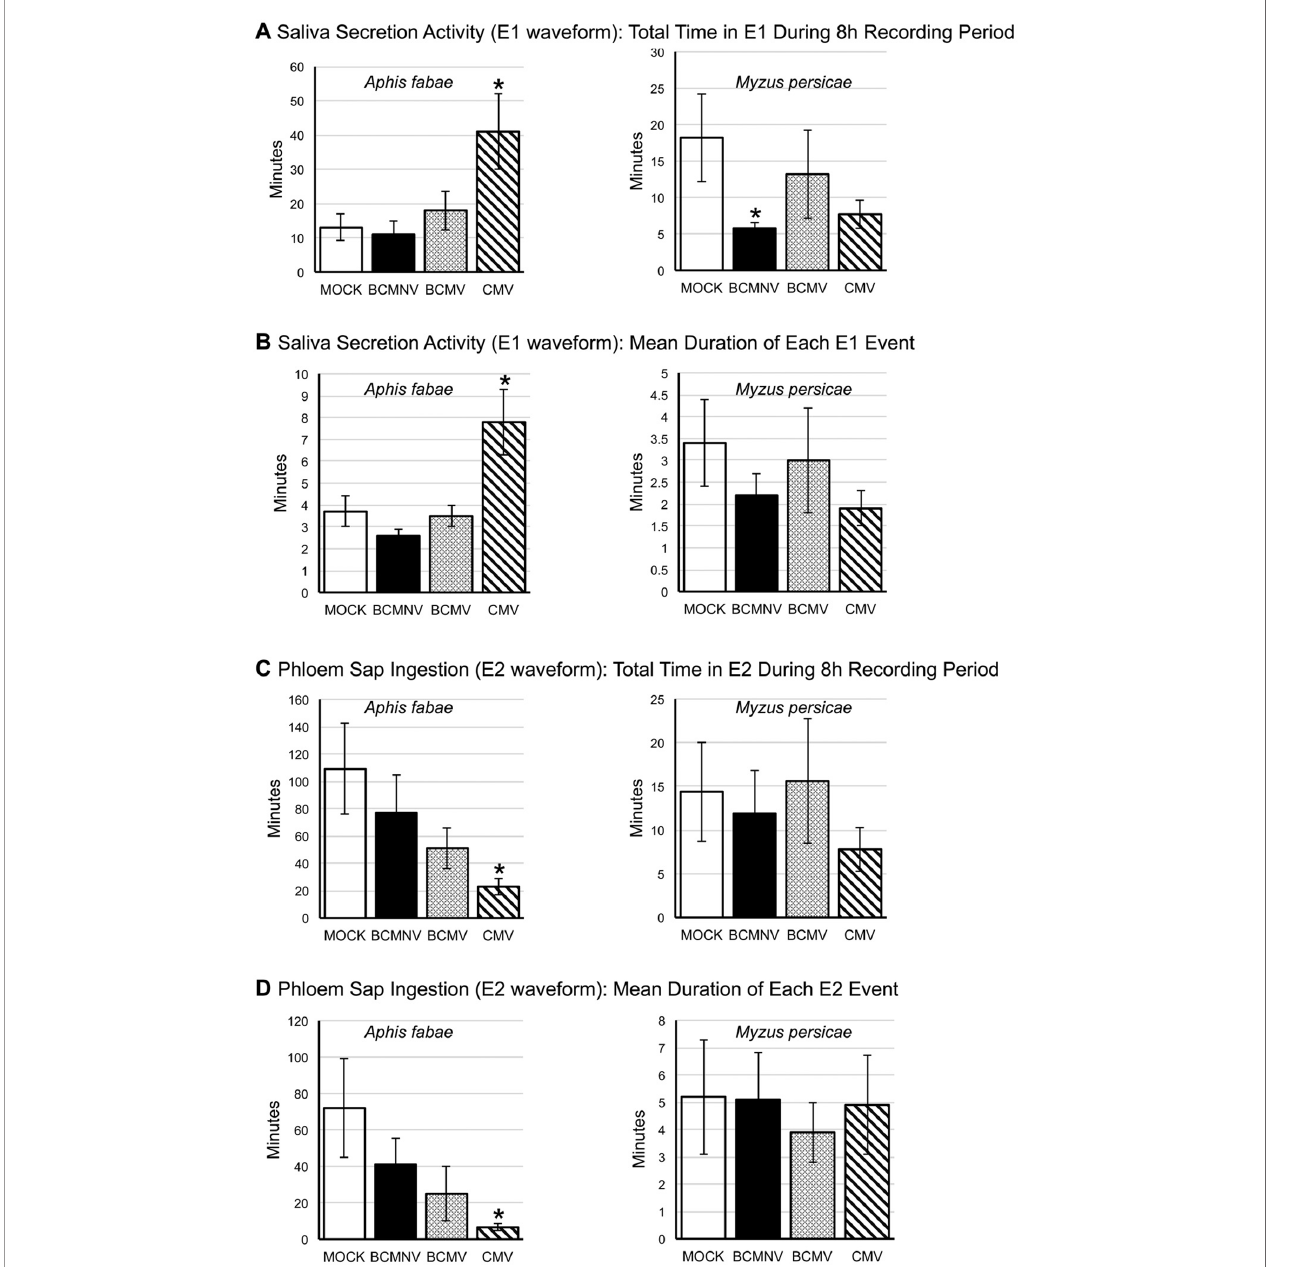
FIGURE 3 | Analysis of differences in aphid salivation into the phloem and phloem sap ingestion for Aphis fabae and Myzus persicae on mock-inoculated and virus- infected plants. EPG data was analyzed for changes in salivation into the phloem (E1 waveform: A, B ) and subsequent phloem sap ingestion (E2 waveform: C, D ) by the legume specialist A. fabae (left panels) and the generalist M. persicae (right panels) on common bean plants that had been mock-inoculated or infected with bean common mosaic virus (BCMV), bean common mosaic necrosis virus (BCMNV), or cucumber mosaic virus (CMV). A. fabae placed on CMV-infected plants spent signi fi cantly longer ( p = 0.0161) salivating into the phloem than on plants that were mock-inoculated (A) , and this was consistent with a corresponding signi fi cant difference for the mean duration of incidents of sap ingestion ( p = 0.0236) (B) . The total time A. fabae spent phloem feeding was signi fi cantly reduced on CMV- infected plants ( p = 0.00059) (C) as was the mean duration of phloem ingestion bouts ( p = 8.0.10 − 5 ) (D) . A. fabae on plants infected with BCMV showed a similar trend of decreased phloem activity, although this was not statistically signi fi cant (A – D) . On mock-inoculated plants M. persicae and A. fabae spent similar periods of time salivating into the phloem (A, B) . However, on mock-inoculated plants, the phloem ingestion bouts of M. persicae averaged 5 min compared to 70 min for A. fabae (D) , which was re fl ected in the overall times spent feeding from the phloem by the two species (C) . The only statistically signi fi cant effect seen for M. persicae was a decrease in overall time spent in salivation on BCMNV-infected plants ( p = 0.0427) (A) . Asterisks denote values signi fi cantly different from mock treatments (Dunnett p < 0.05). The error bars represent the standard error of the